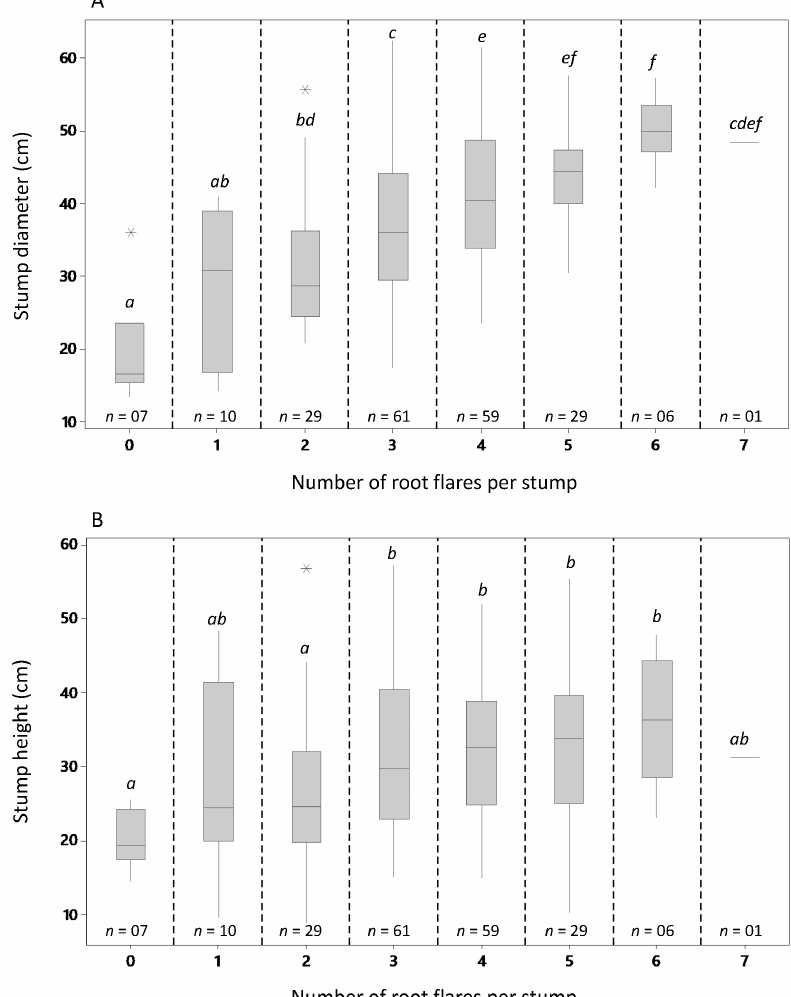
Figure 8. The influence of the number of root flares per stump on ( A ) stump diameter; and ( B ) stump height. Different lower case letters indicate a statistical difference at alpha 0.05 between the number of root flares per stump and stump diameter or height.